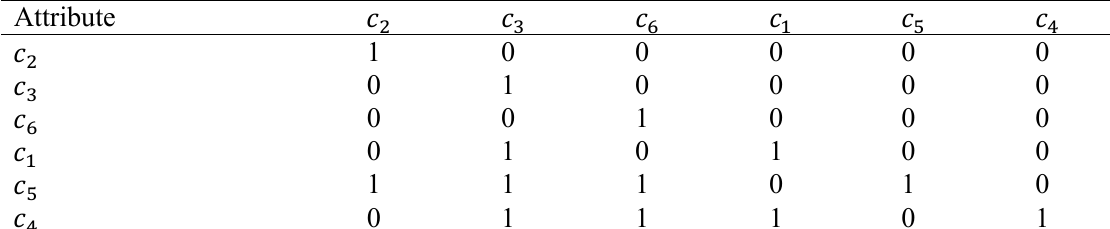
Fig. 2. Table 12 Lower triangular matrix for evaluation problem